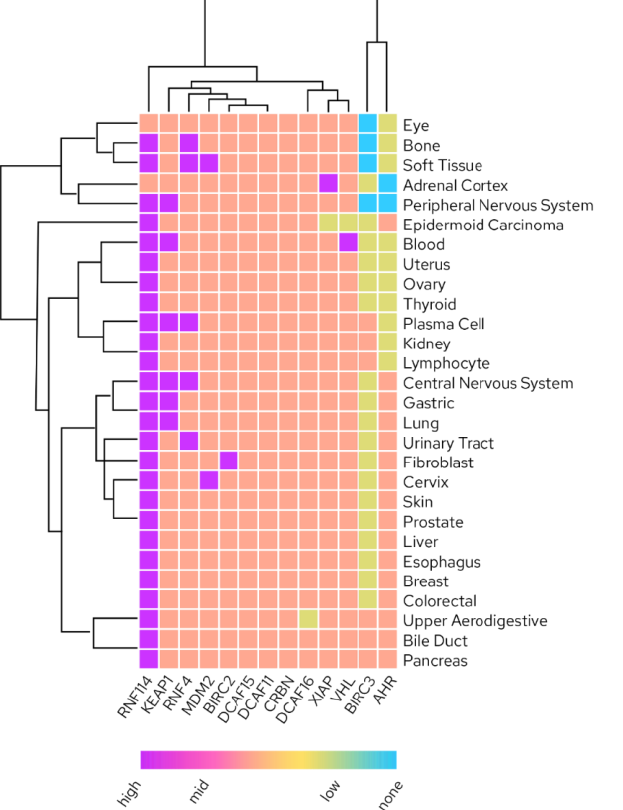
Figure 4. Tissue RNA expression of liganded E3 ligases (Human Protein Atlas; proteinatlas.org accessed on 1 October 2022).